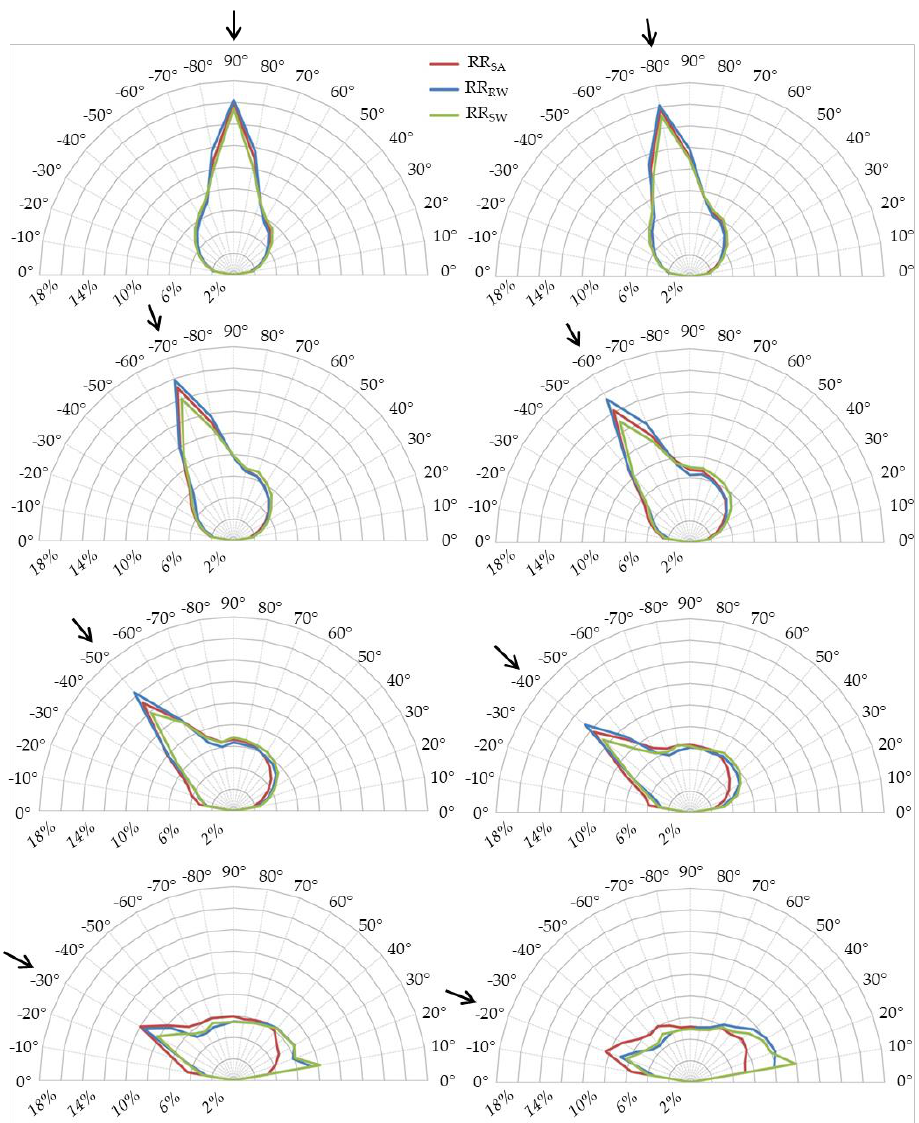
Figure 6. Angular reflectivity profiles of RR samples: RR SA (red solid line), RR RW (blue solid line), and RR SW (green solid line), for each direction of incident radiation from 90° to −20°.